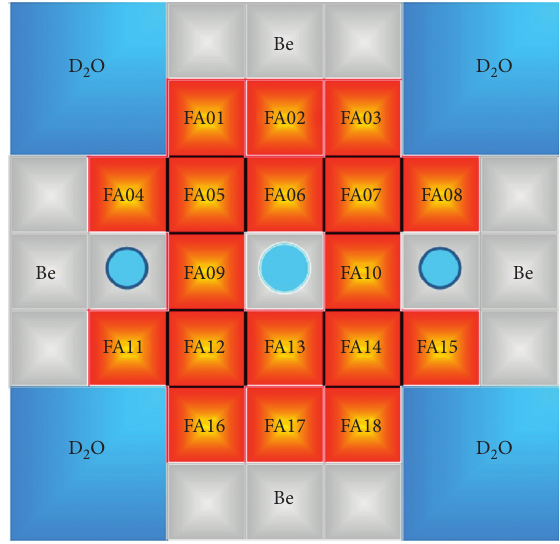
Figure 1: Cross-sectional ( x - y ) view of the JRTR reactor core